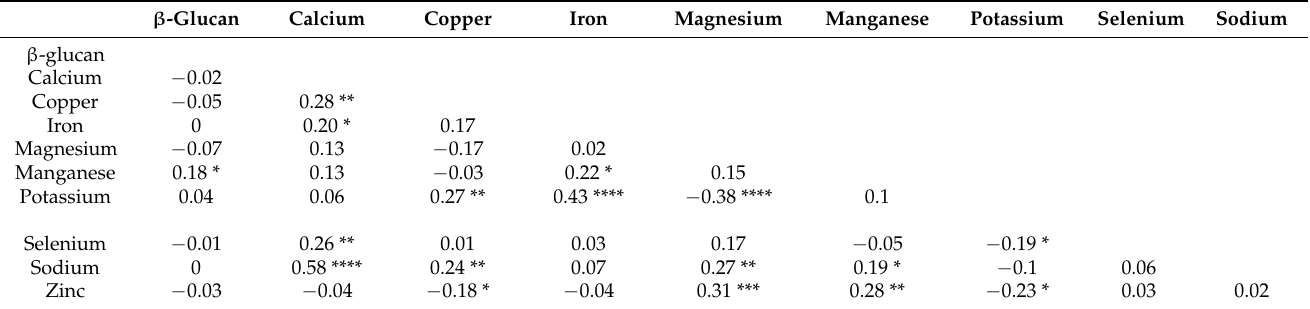
Table 6. Correlations among β -glucan and micronutrients contents of Hordeum spontaneum bulked seed accessions. β -Glucan